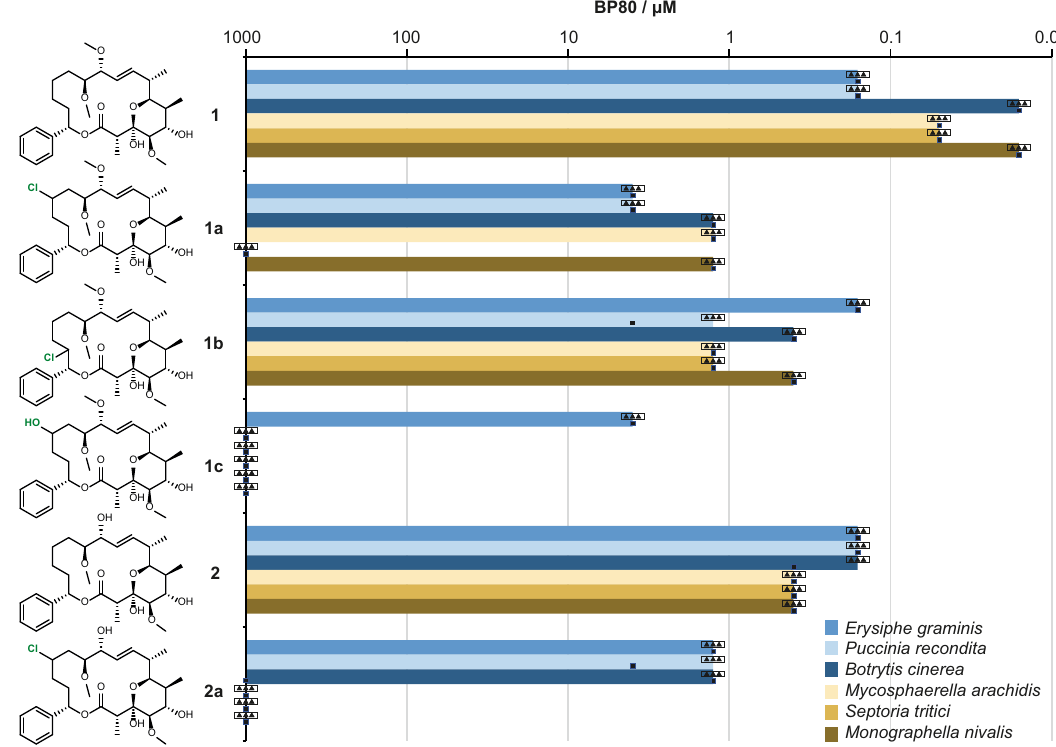
Fig. 5 Break point of ef fi ciency 80% (BP80). Soraphen A ( 1 ), C ( 2 ), and enzymatically derivatized analogs ( 1a , 1b , 1c , 2a ) were tested against six different fungi, determined by dilution series at four concentrations and measured against positive and negative standards. BP80 represents the concentration of active ingredients above which 80% or more of ef fi ciency is observed. The experiments on living organisms were performed in two test series (biological replicates). The fi rst series consisted of a single experiment ( N = 1, square) for each fungus, the second series consisted of triplicates with three samples tested in parallel during the same test session ( N = 3,